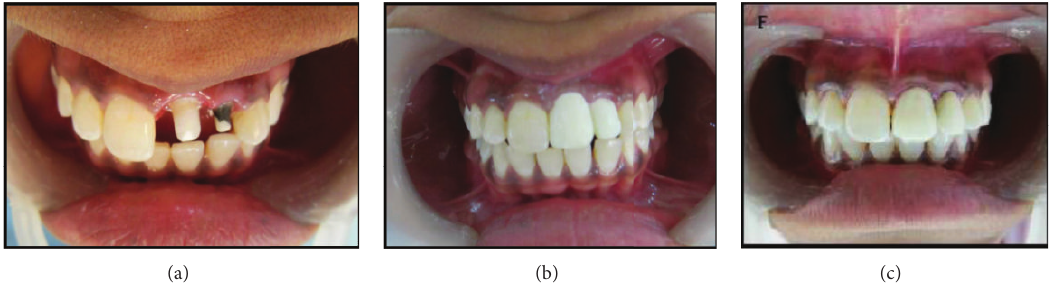
Figure 2: (a) Build-up with composite and tooth preparation. (b) Temporization with acrylic crowns. (c) Permanent cementation of PFM